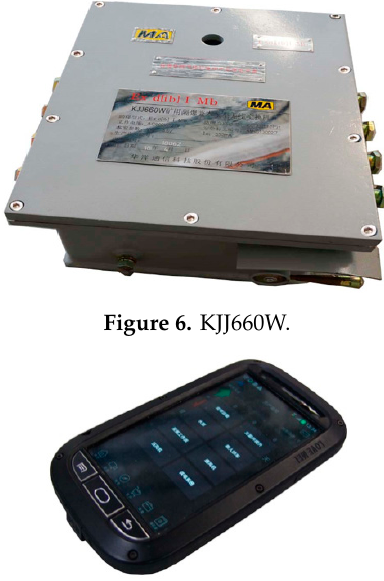
Sensors 2020 , 20 , x FOR PEER REVIEW Figure 7. The intrinsic safety mobile phone. Figure 7. The intrinsic safety mobile phone. Figure 7. The intrinsic safety mobile phone. Figure 7. The intrinsic safety mobile phone.